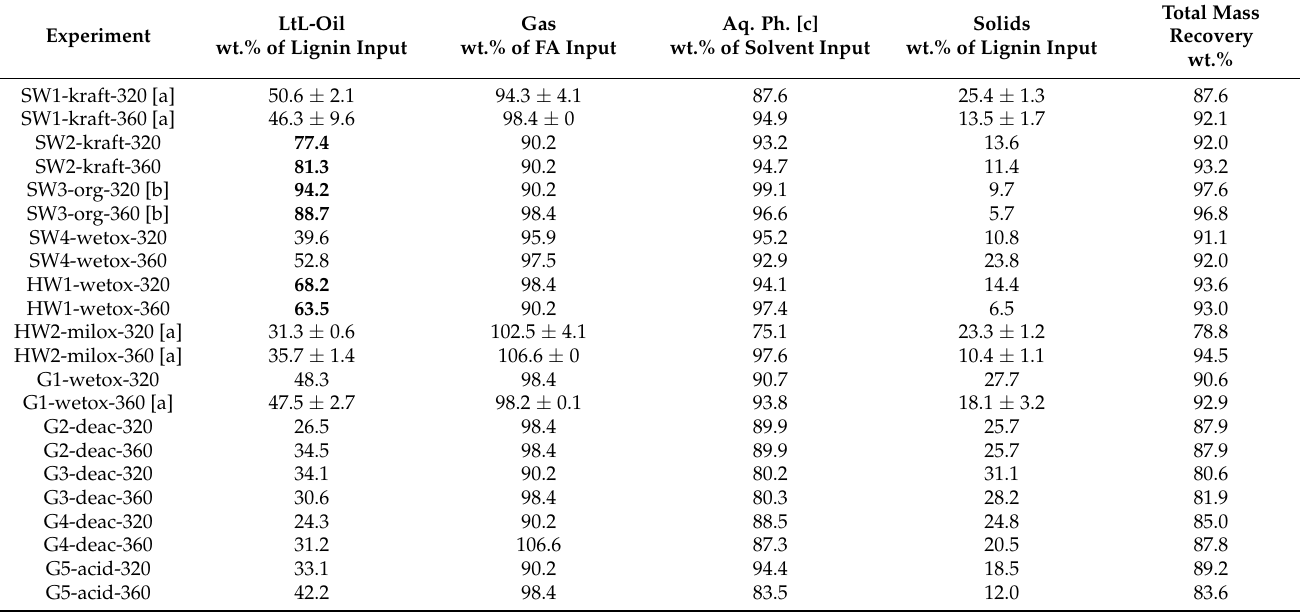
Table 6. Results from LtL-solvolysis, yields. The naming of the experiments is specified in Table 3 in the experimental section. The experiments with an oil yield of more than 60% are in